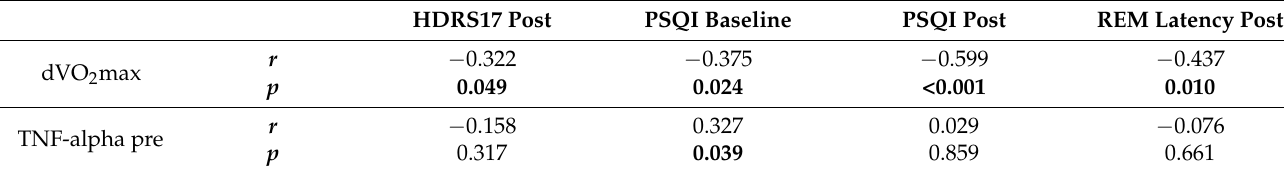
Table 4. Pearson’s